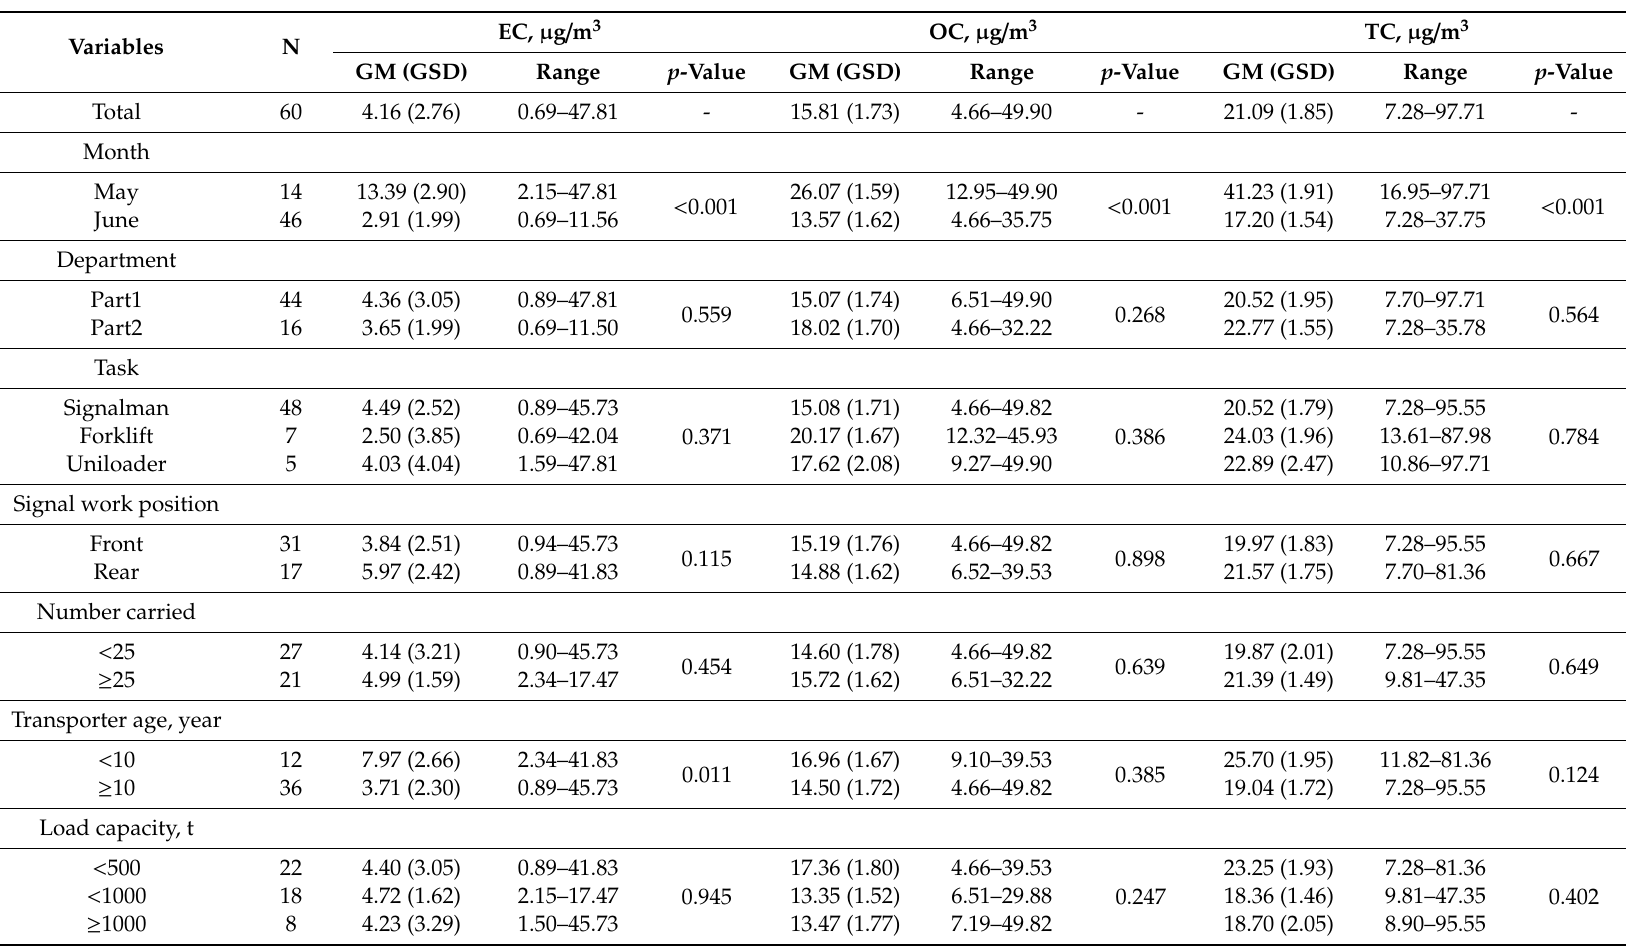
Table 2. Exposure levels of elemental carbon (EC), organic carbon (OC), and total carbon (TC) in transporter signal work according to variables.